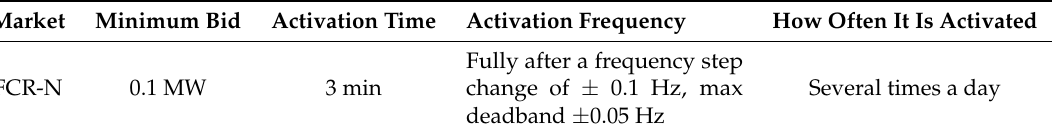
Table 1. FCR-N market technical requirements as specified in